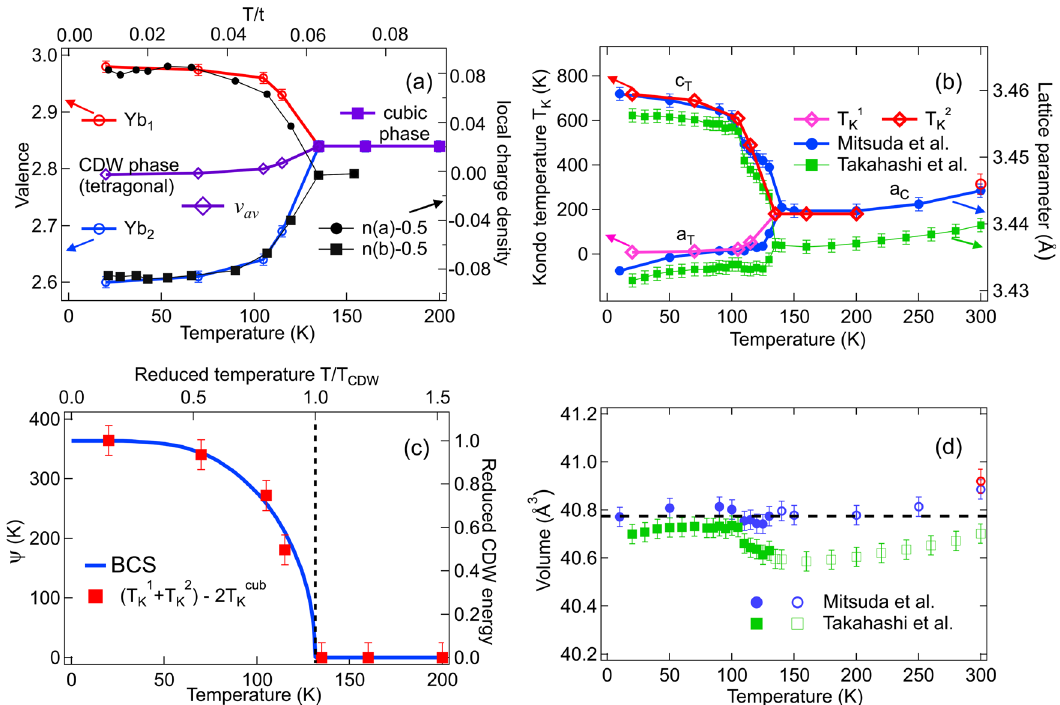
Fig. 4 Coupling of CDW order, Kondo energy scales, and lattice parameters leading to zero-thermal expansion. a Below the CDW transition at T = 130 K, the two different Yb sites exhibit T -dependent valencies, whereas above T 1 1 the valency of the unique Yb site is constant up to 200 K. The calculated local charge density, n (a) and n (b) ( ● , ■ ) as a function of T/t , where T is temperature and t is the hopping integral (ref. 12 ). It shows a gradual CDW formation indicating a second-order transition. b Comparison of T -dependent Kondo temperatures and lattice-parameters (refs. 27,35 ) across the cubic-to-tetragonal CDW phase transition. The cubic lattice-parameter measured for present sample at T = 300 K is shown as a red circle ( ). c T -dependence of the Kondo energy balance showing CDW order parameter follows the BCS model. d Plot of cubic unit-cell volume (> T 1 ) with cell-volume V = a ´ b ´ c = half the tetragonal unit-cell volume (< T T . The solid and open symbols represent the tetragonal and cubic phases, T T T ( 1 ), as a function of respectively. The cell-volume V shows ZTE within error bars in the low- T CDW phase; error bars based on data of lattice-parameters from Mitsuda et al. 27 and Takahashi et al. 35 . The measured cell volume at T = 300 K for present sample is shown as red circle ( ). The dashed line (----) is the average cell volume below T 1 . For T > T 2 = 105 K, the cell-volume V for data from ref. 35 shows slightly larger deviation compared to ref. 27 . Error bars represent standard error (SE). Table 1 Hybridization strength values, number of holes, and Kondo temperatures.